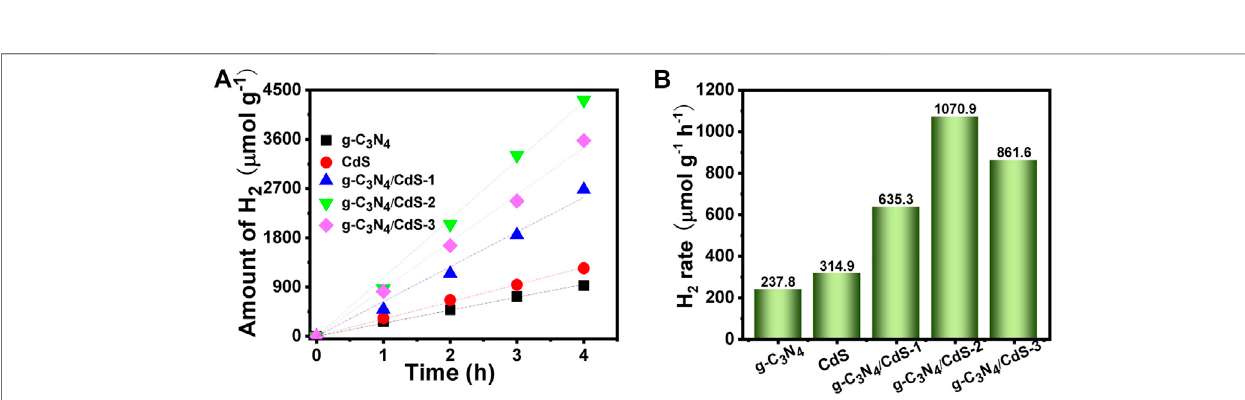
FIGURE 7 | (A,B) Photocatalytic hydrogen evolution on g-C 3 N 4 , CdS, and g-C 3 N 4 /CdS hybrids under visible light.